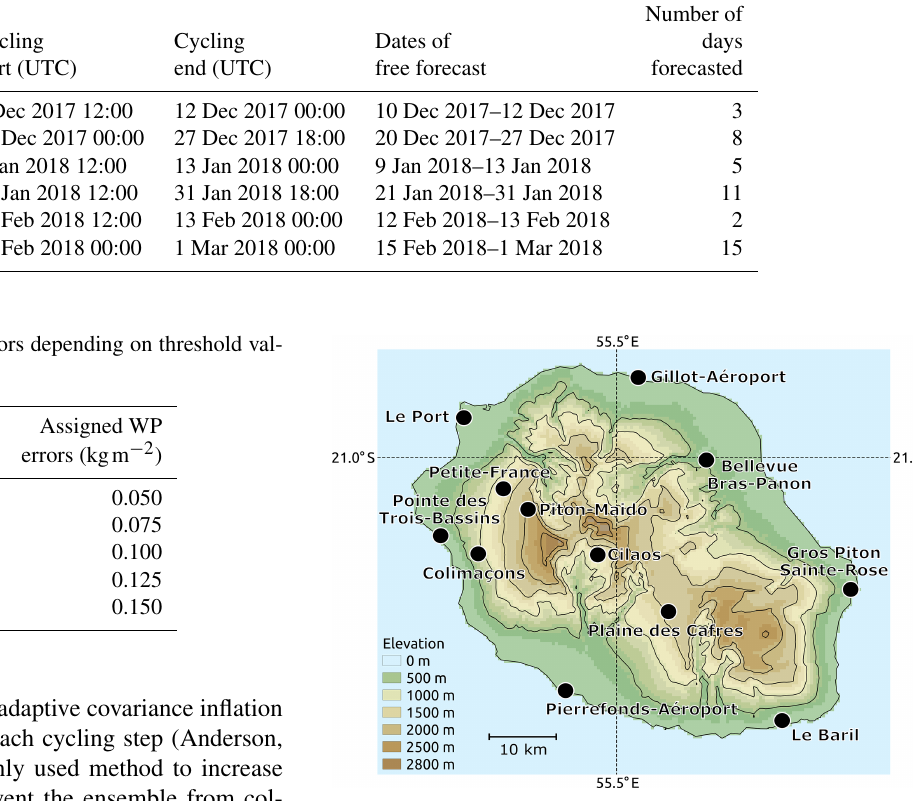
Table 1. Overview of the cycling experiment periods and the associated free forecast experiment and dates. Cycling Cycling Cycling Dates of days period start (UTC) end (UTC) free forecast forecasted